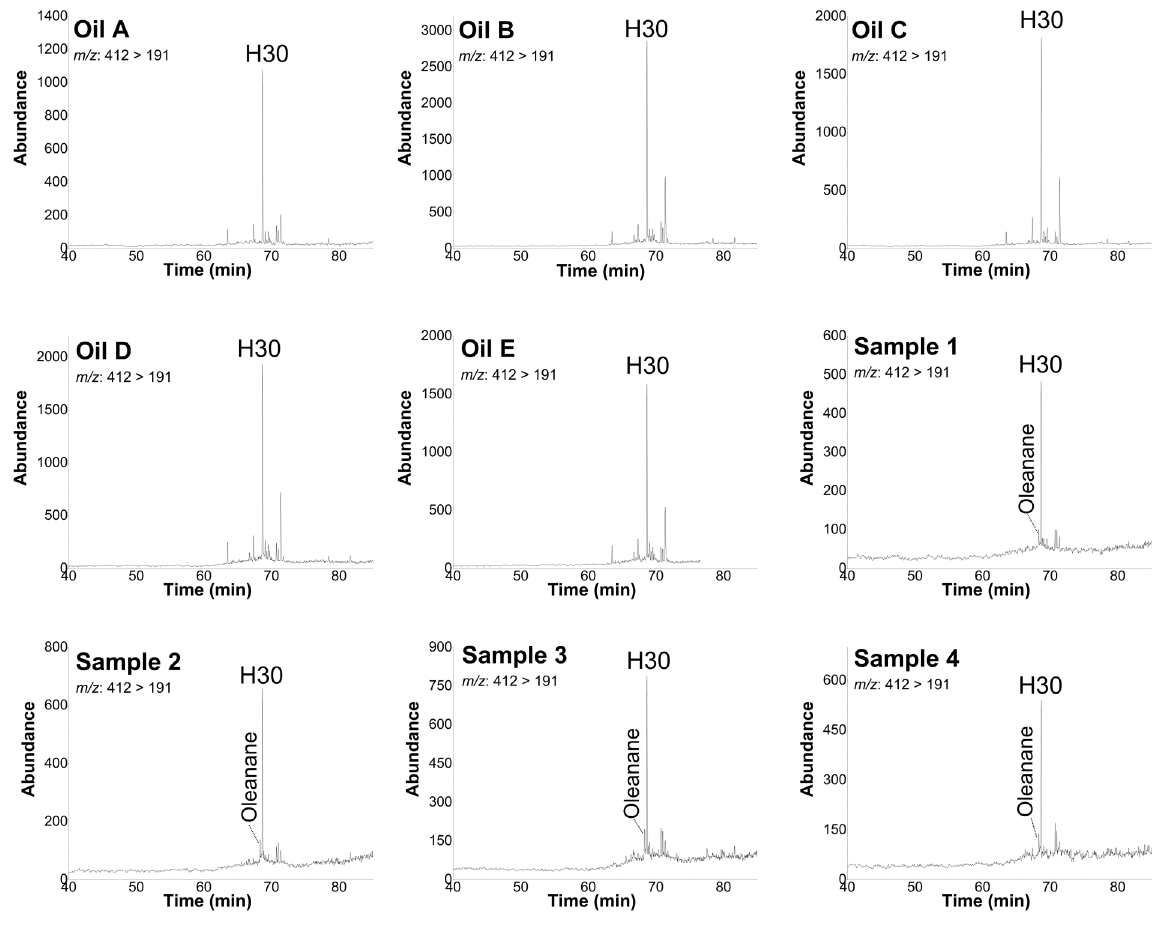
Figure 3. Expansion of the chromatograms for the transition m/z 412>191 used to identify the presence or absence of the 18α(H)-oleanane biomarker in the